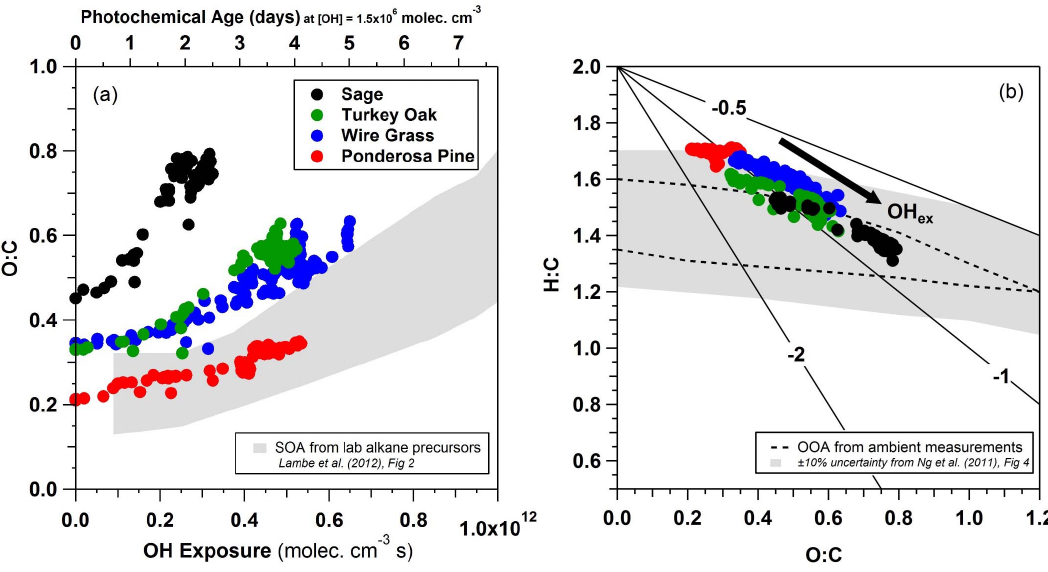
Fig. 12. Effect of smoke aging on OA elemental composition. (a) Oxygen-to-carbon (O/C) ratio of aged smoked as a function of OH exposure for four fuels. Results from laboratory experiments using a flow reactor to investigate SOA from alkane precursors are shown in gray from Lambe et al. (2012). (b) Van Krevelen diagram, showing H/C vs. O/C for four fuels. Solid lines are slopes from Heald et al. (2010), dashed lines are ambient measurements of OOA data first presented in f 44 /f 43 space in Ng et al. (2010), and are transformed into Van Krevelen space in the work of Ng et al. (2011) with shaded region denoting ± 10% uncertainty. Figure 13.